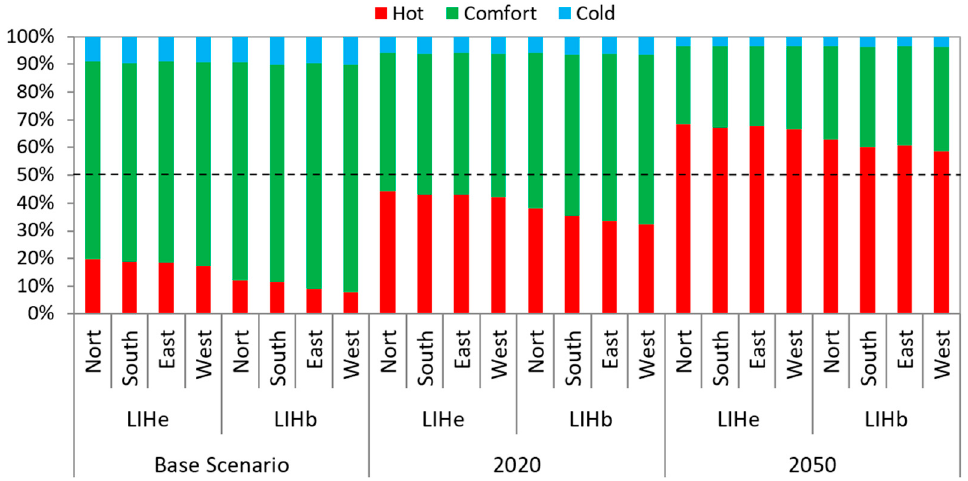
Figure 8. Weighted percentage of comfort and discomfort hours inside the LIHe and LIHb in the base and future scenarios.